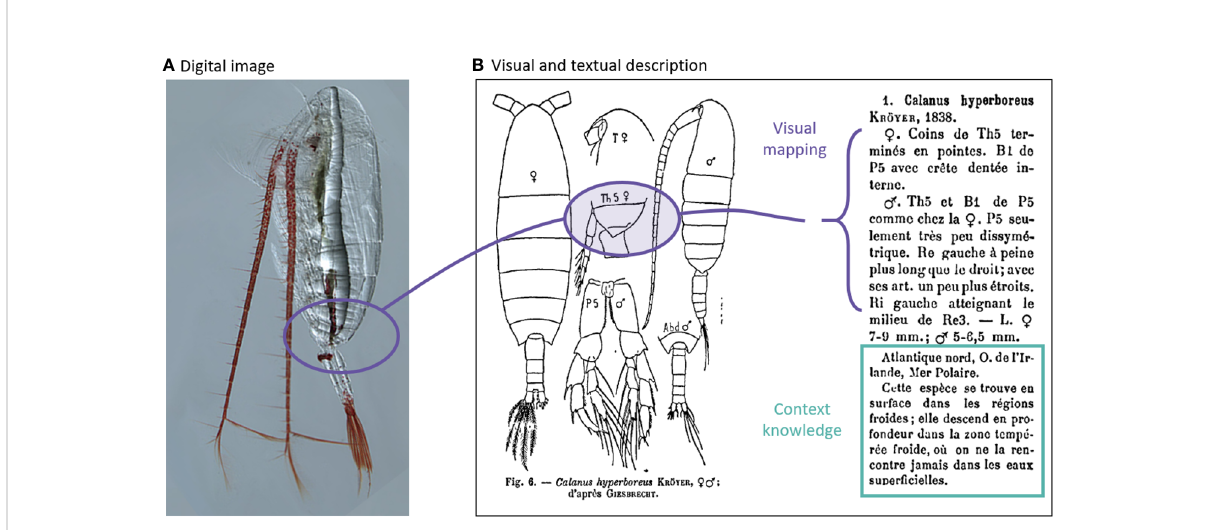
FIGURE 10 Multimodal learning uses both image and text data. (A) Image of Calanus hyperboreus (Source: Hopcroft at arcodiv.org). (B) Taxonomic description of Calanus hyperboreus (Rose,